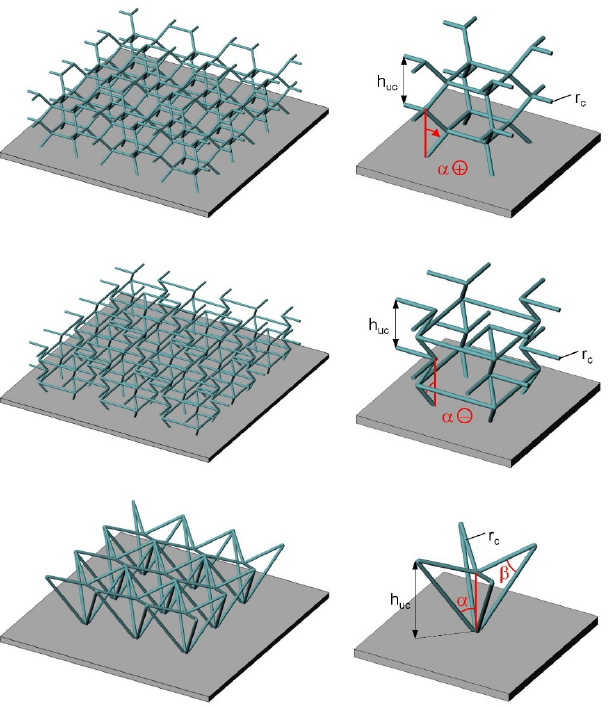
Figure 8. Three ‐ dimensional lattice core variants with associated unit cells and geometry parame ‐ (one-layer, 1L). From top to bottom: non-auxetic honeycomb cell, auxetic honeycomb cell, and auxetic ters (one ‐ layer, 1L). From top to bottom: non ‐ auxetic honeycomb cell, auxetic honeycomb cell, and auxetic arrow geometry. arrow